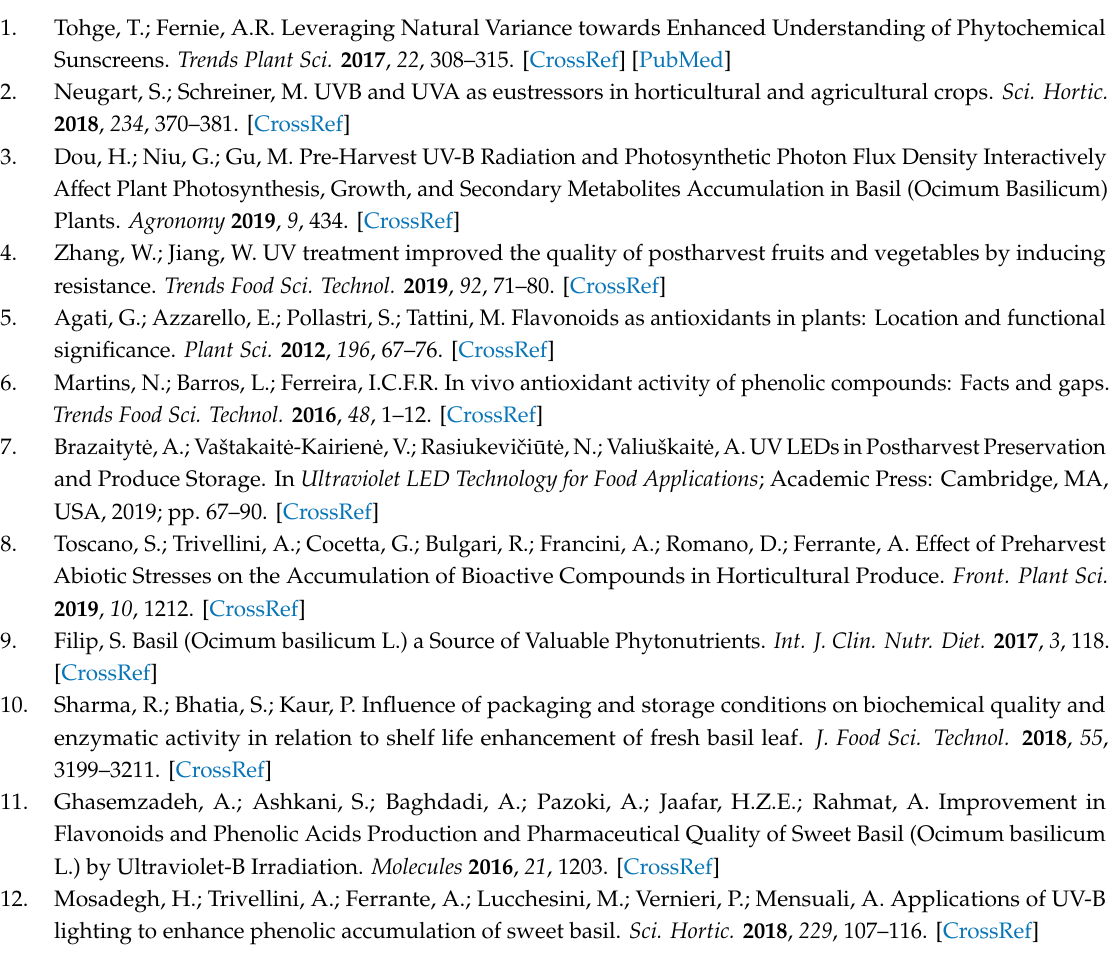
Figure S1: Flav Index in the adaxial epidermis (a) and abaxial epidermis (b) of leaves of O. basilicum plants cultivated under white light and supplemental UV-B radiation extracted immediately after the light treatment (before storage T S0 ) or after seven days of storage (T S7 ); Figure S2: Representative chromatograms of Ocimum basilicum leaf extracts at 280 and 330